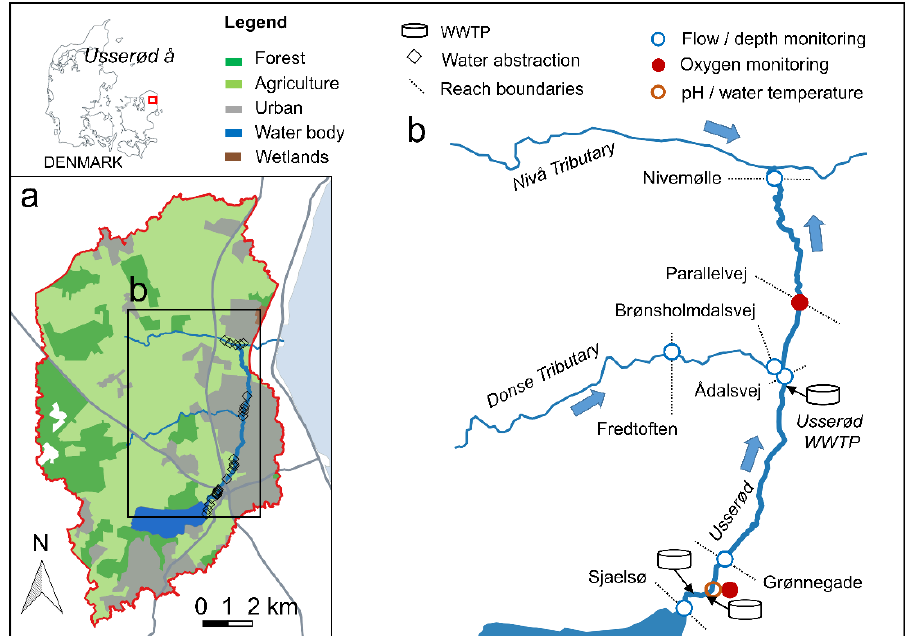
Figure 2. Overview of the Usserød catchment with stream and tributary ( a ) general land use [71] and abstraction well location along the stream, ( b ) key urban features (WWTP) and available monitoring network. The reach boundaries are also displayed and set by the monitoring stations for verification purposes [72]. Each reach is named after the corresponding downstream monitoring station in this study.